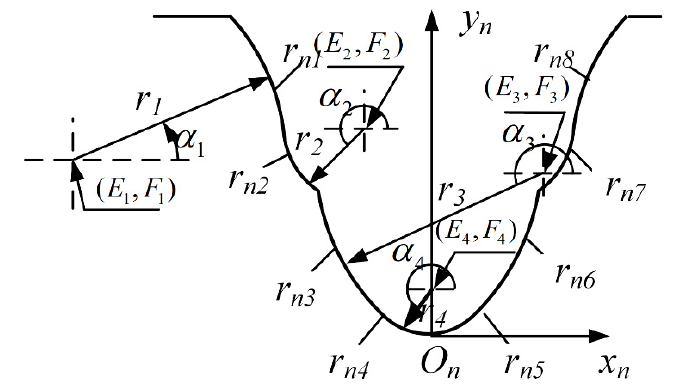
Figure 2. Double circular arc basic tooth profile (GB/T12759-1991). The coordinate system is established on the face balance line of the double circular arc teeth. The coordinates of any point on each circular arc can be determined by using the circular arc radius ( E i , F i ) and the starting and ending positions angle of the circular